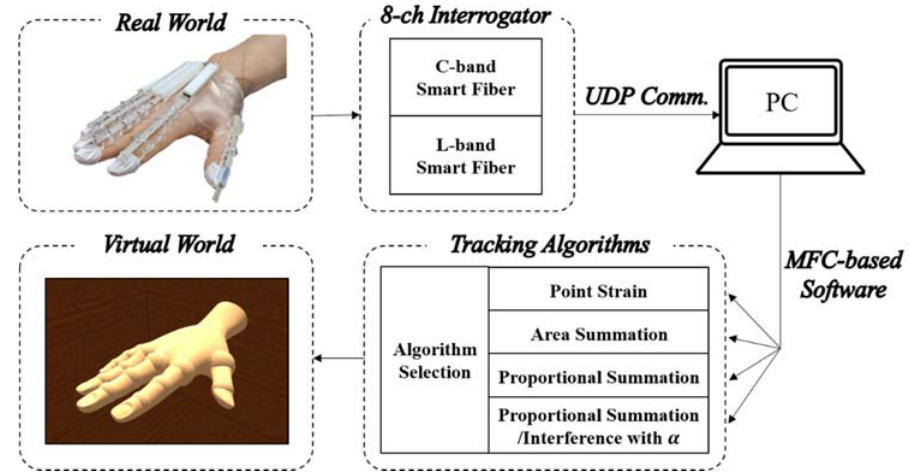
Figure 4. Schematic diagram of the FBG interrogation system for real ‐ time tracking of the finger joint angle.